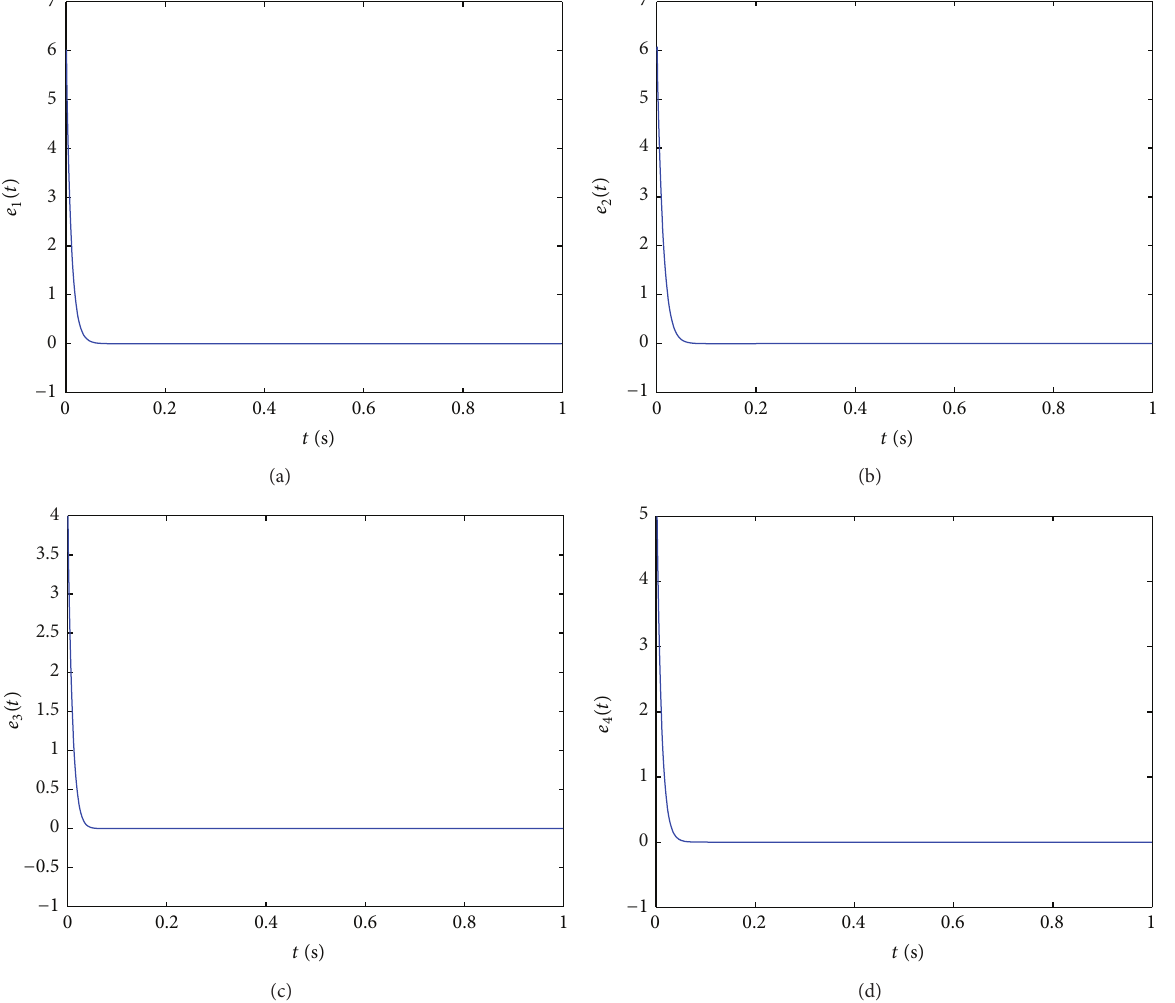
Figure 5: Time waveforms of synchronization errors 𝑒 1 (a), 𝑒 2 (b), 𝑒 3 (c), and 𝑒 4 (d) between two fractional-order hyperchaotic Lorenz